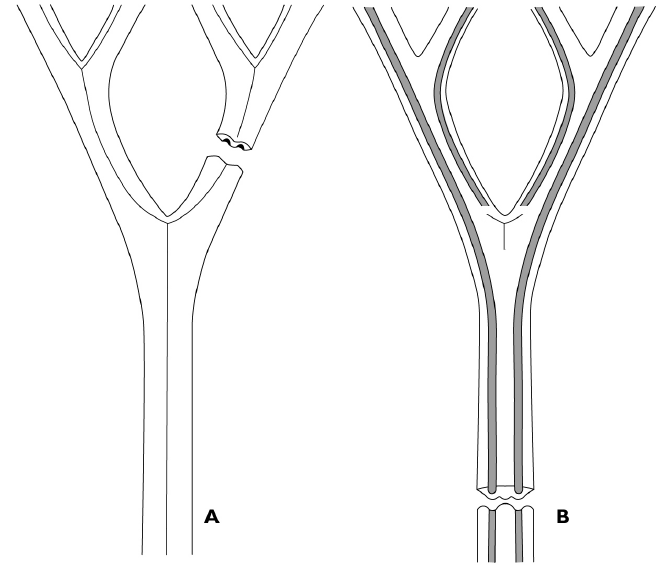
Figure 7. Diagram of leaf structure: A Reconstruction of the adaxial leaf side of Dicranophyllum gal- licum , note the path of the midvein in the second segment of the leaf B Reconstruction of the abaxial leaf side of Dicranophyllum gallicum , note the prominent furrows and the absence of a clear midvein.